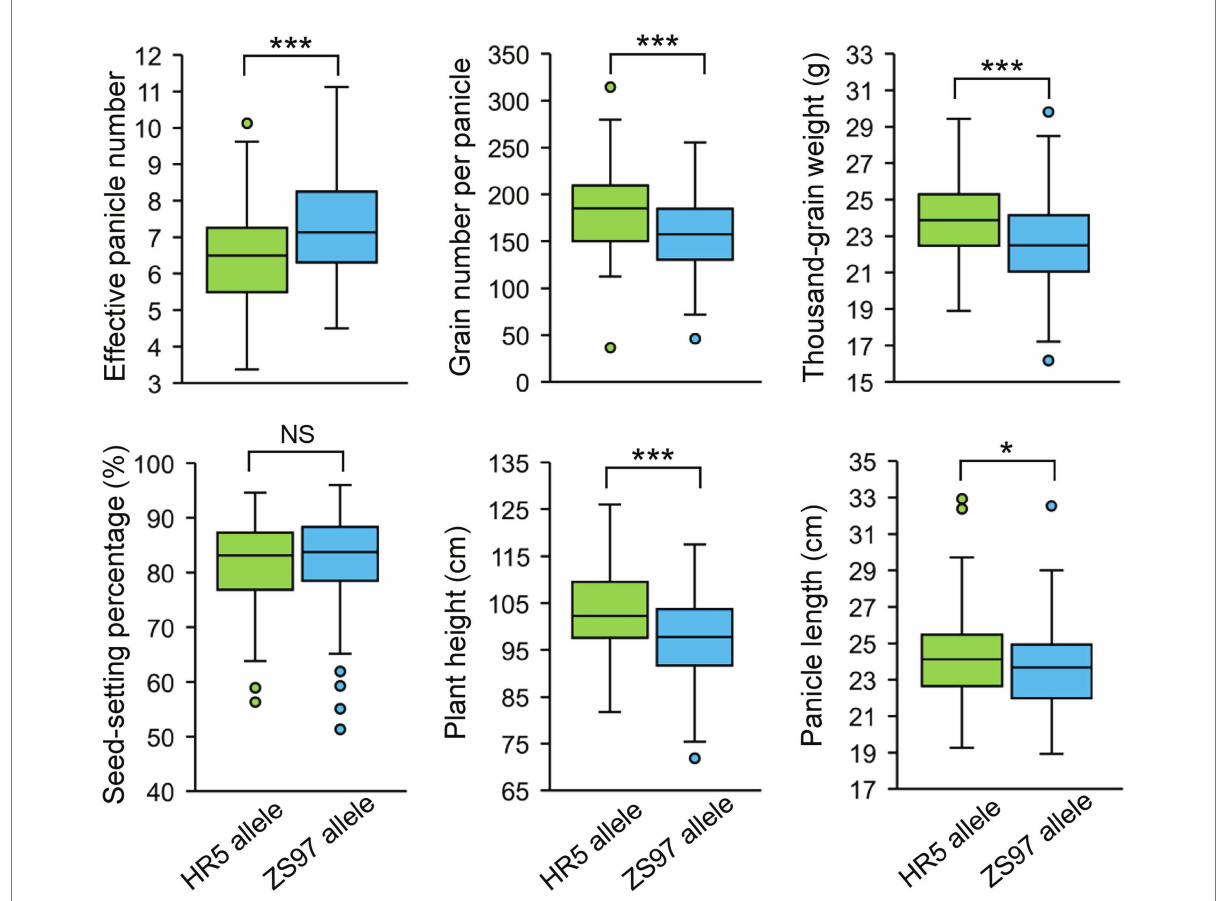
FIGURE 6 Performance of the qEPN-HN4 alleles in the RIL population under HN conditions. *** p < 0.001, * p < 0.05; NS, not